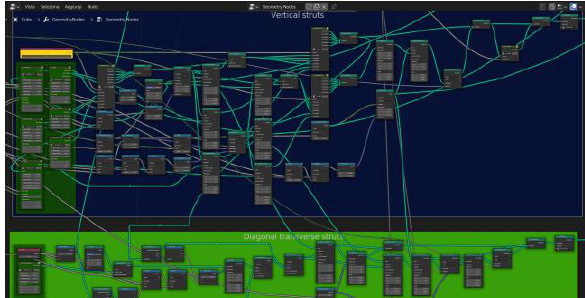
Figure 7 . The grouping of Blender’s Gemetry Nodes in Frames and the relative second level of input